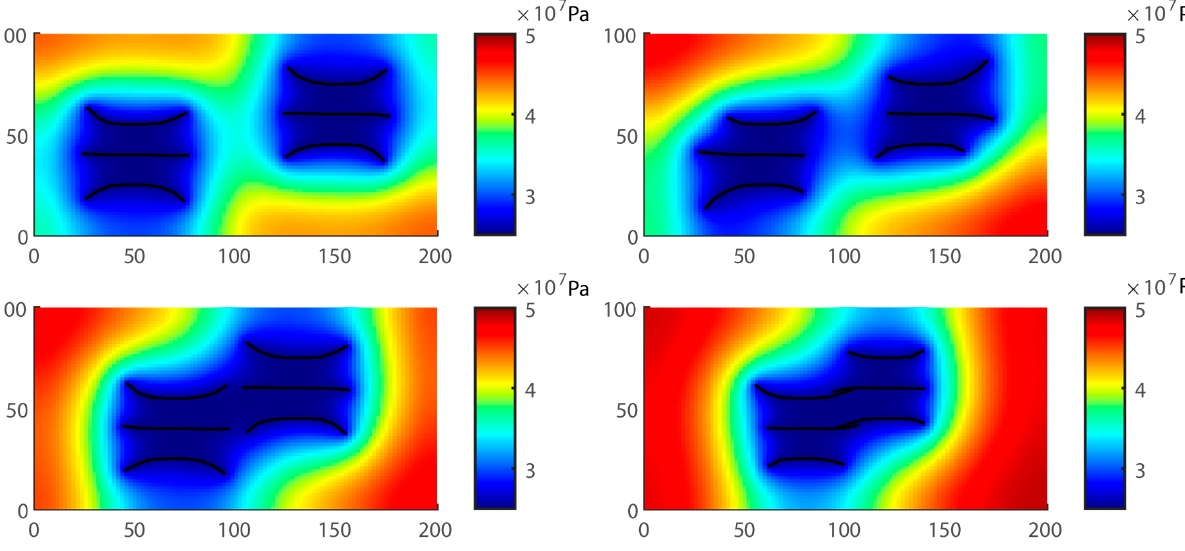
Figure 18. Pressure field after 2000 days (well-spacing = 100, 80, 60, and 40 m).